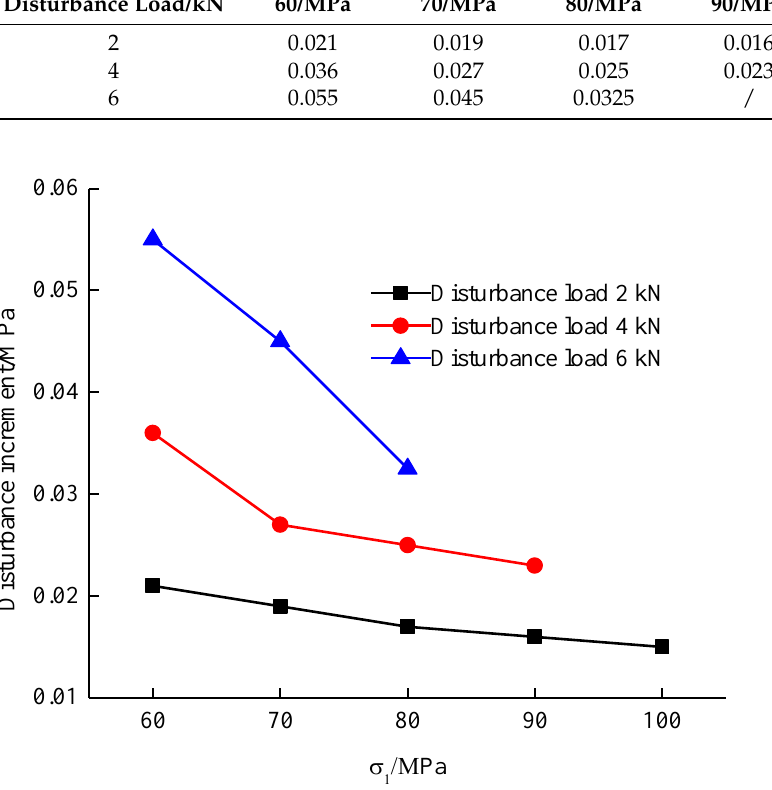
Figure 6. Different σ 1 creep increment curves for lower disturbance levels.